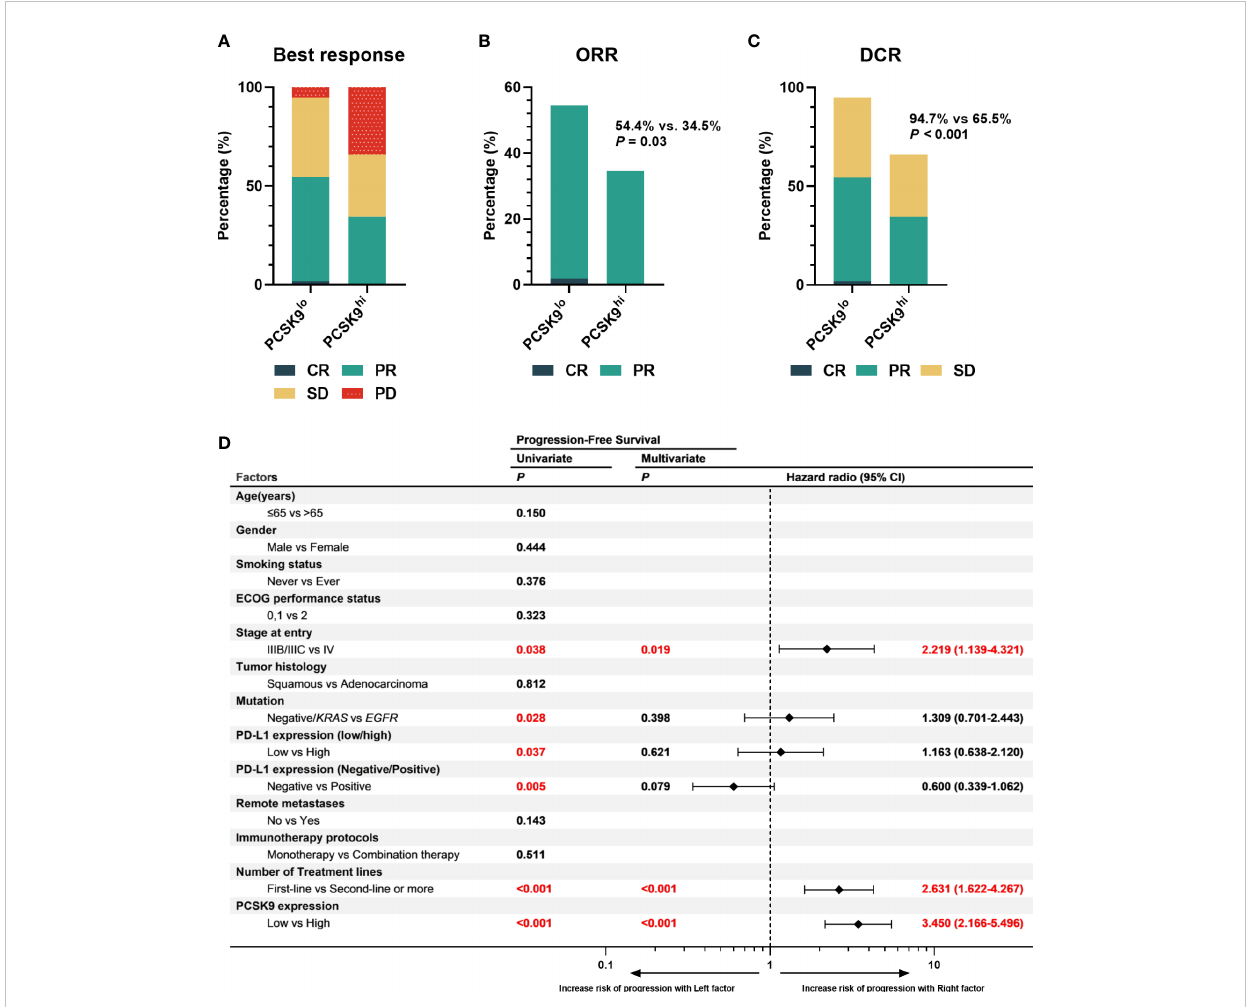
FIGURE 2 High expression of PCSK9 in NSCLC tissues was associated with poorer ef fi cacy of anti-PD-1 immunotherapy in advanced NSCLC. (A) Best response of the PCSK9 hi and PCSK9 lo groups. (B) ORR of the PCSK9 hi and PCSK9 lo groups. (C) DCR of the PCSK9 hi and PCSK9 lo groups. (D) Univariate and multivariate analyses of factors associated with PFS. PD-L1 negative, TPS < 1%; PD-L1 low, TPS < 50%; PD-L1 high, TPS ≥